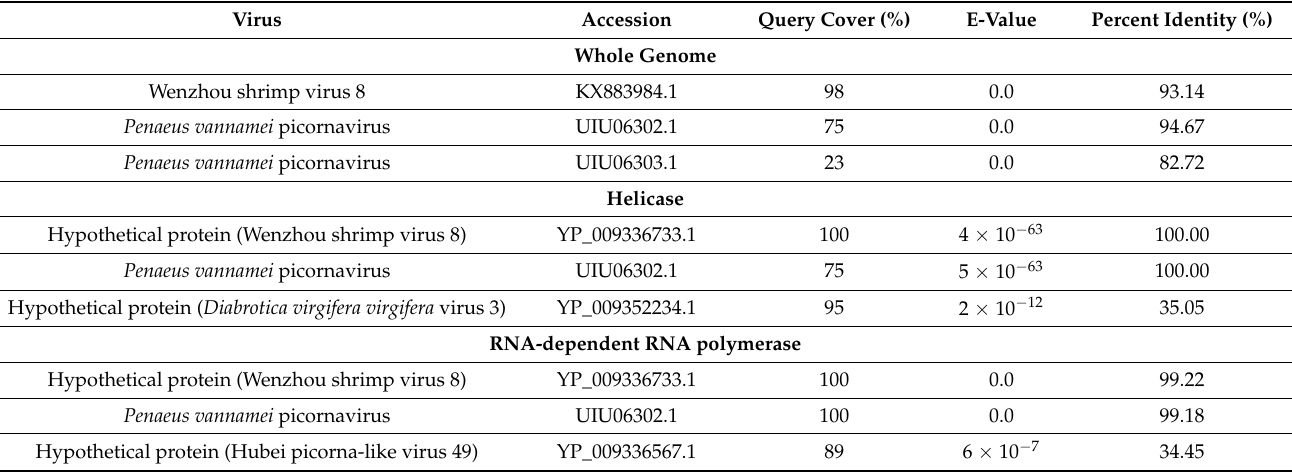
Table 2. Amino acid sequence similarity of ORF1, Helicase and RNA-dependent RNA polymerase of Penaeus vannamei solinvivirus (PvSV) to other viruses from GenBank.